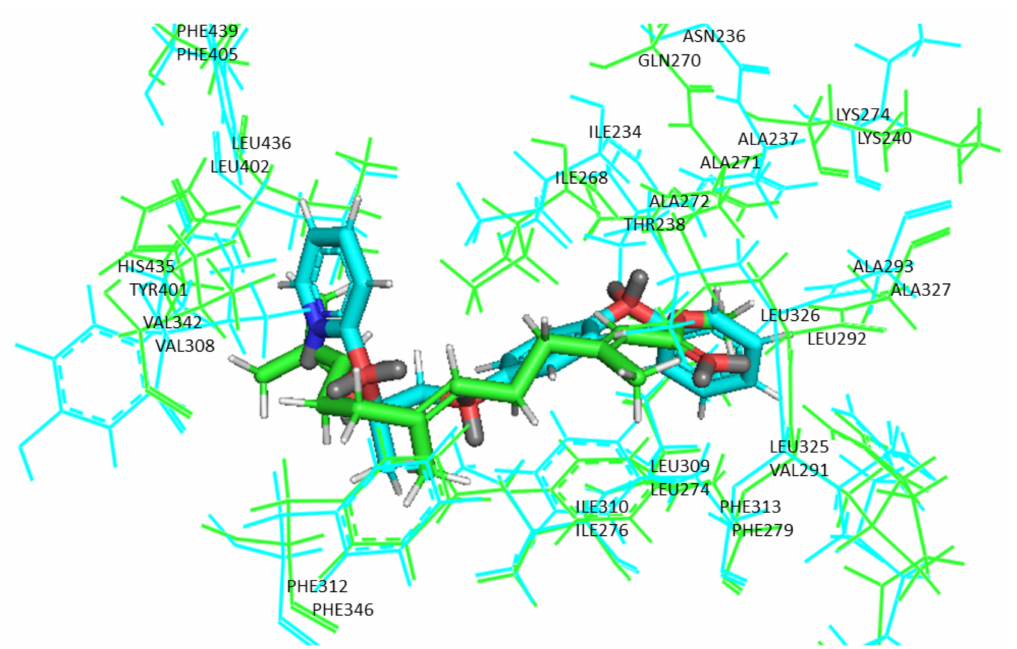
Figure 2. The binding pocket residues of RXR α (in blue) and USP (in green) in complex with pyriproxyfen and juvenile hormone III,